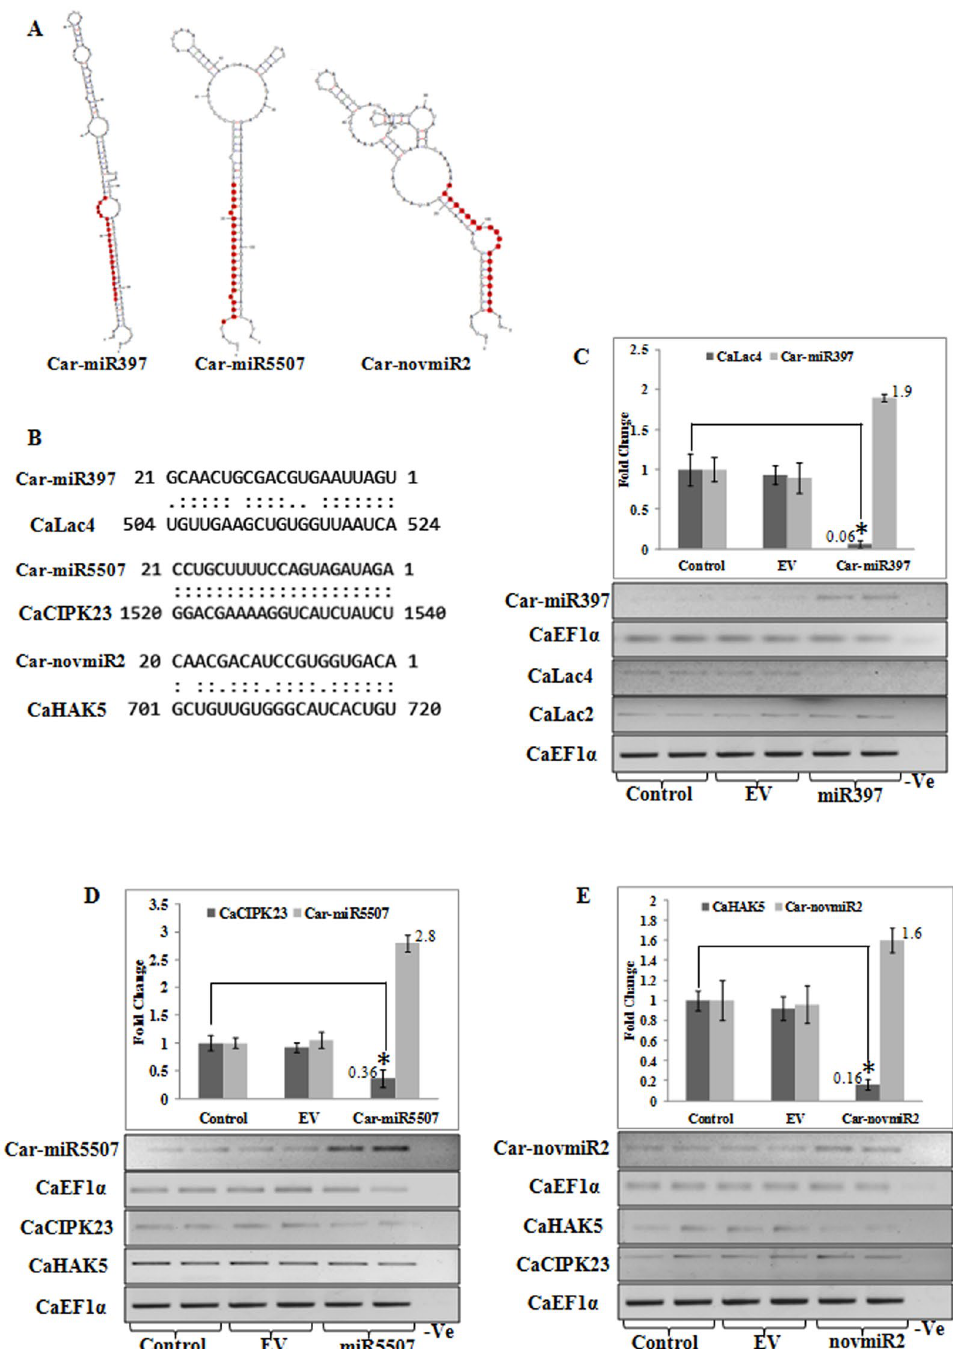
Figure 6. Validation of predicted miRNA targets. ( A ) Predicted secondary structures of miR397, miR5507 and novmiR2. ( B ) Predicted target sequences of miR397, miR5507 and novmiR2. ( C – E ) Candidate miRNA-target interaction was validated by transient over-expression of miRNA precursor sequence in chickpea leaf tissue by agaroinfiltration and change in expression pattern of their respective target genes was estimated by qRT-PCR as compared with control sample. The data represent three biological and three technical replicates for qRT- PCR and two independent samples were used for semi-quantitative RT-PCR. * indicates statistically significant change (p < 0.05) in